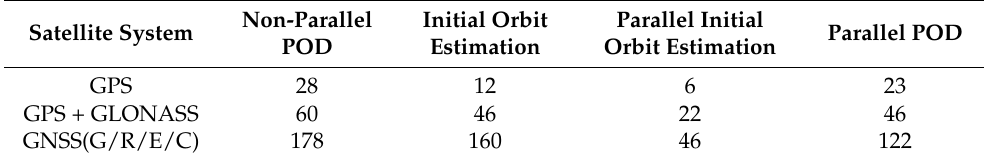
Table 5. Time-consuming statistical results of GNSS parallel and non-parallel POD (unit: min).